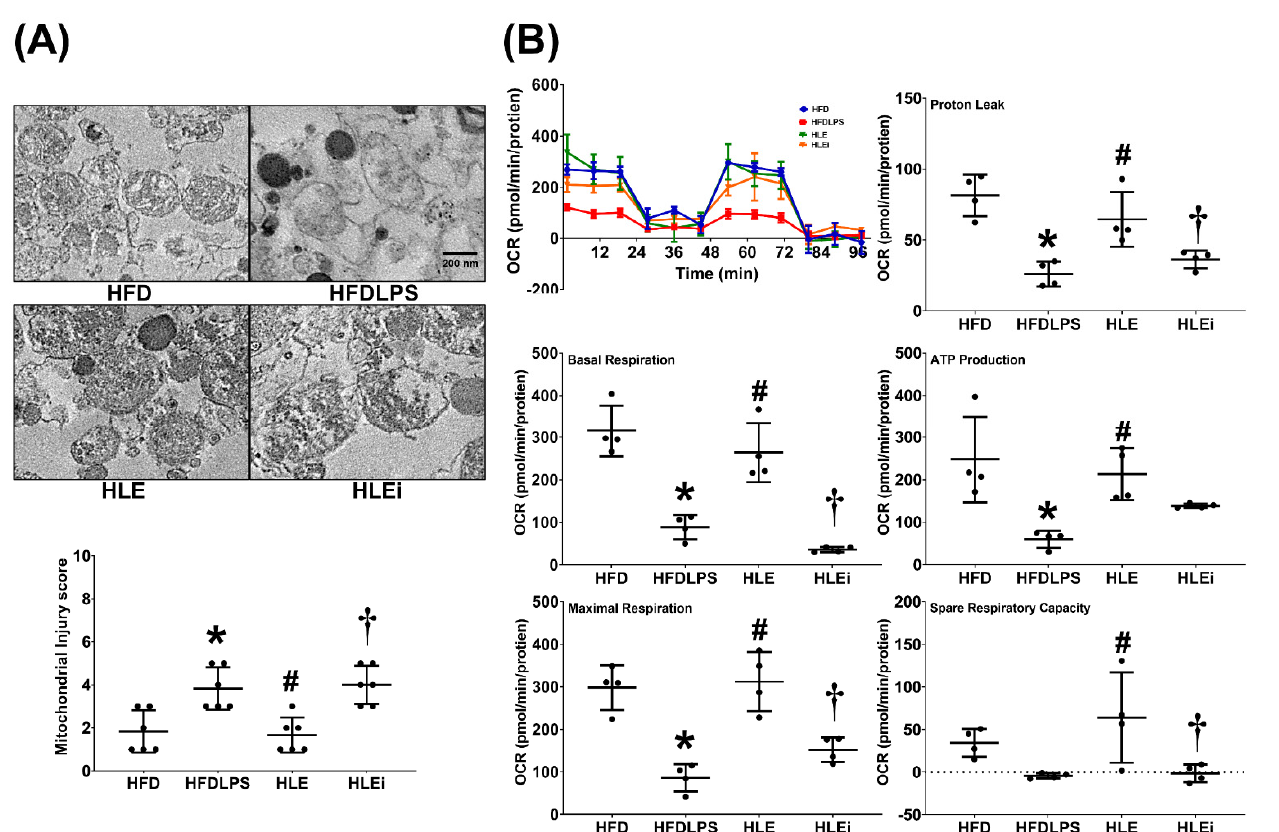
Figure 5. ( A ) Representative transmission electron microscope images of mitochondria morphology (8000×) and mitochondrial injury scores in primary hepatocytes isolated from liver tissues of high-fat diet obese mice. For analysis, 6 mice from each group and 4 random fields per grid (2 µ m 2 ) were selected. ( B ) Representative results of the mitochondrial respiratory function of hepatocytes, determined using a Seahorse Analyzer. Data were derived from 4 mice in each group. All assays were performed 48 h after endotoxin or phosphate buffered saline (PBS) administration in the surviving mice. Data were presented as means ± standard deviations. OCR, oxygen consumption rate. ATP: adenosine triphosphate. HFD: the high-fat diet plus PBS (100 µ L) group. HFDLPS: the high-fat diet plus endotoxin (100 ng/mL) group. HLE: the high-fat diet plus endotoxin plus exo- somes (from human placenta choriodecidual membrane-derived mesenchymal stem cells, pcMSCs, 1 × 10 9 particles) group. HLEi: the high-fat diet plus endotoxin plus microRNA-inhibitor-pretreated exosomes (1 × 10 9 particles) group. * p < 0.05, versus the HFD group; # p < 0.05, the HLE group versus the HFDLPS group. † p < 0.05, the HLEi group versus the HLE